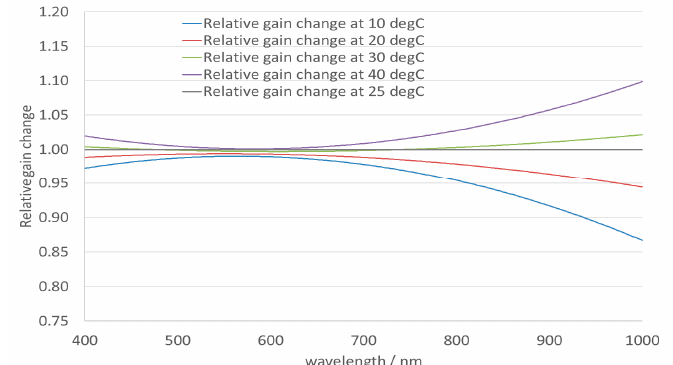
Figure 8. Empirically fitted temperature corrections as a function of wavelength.